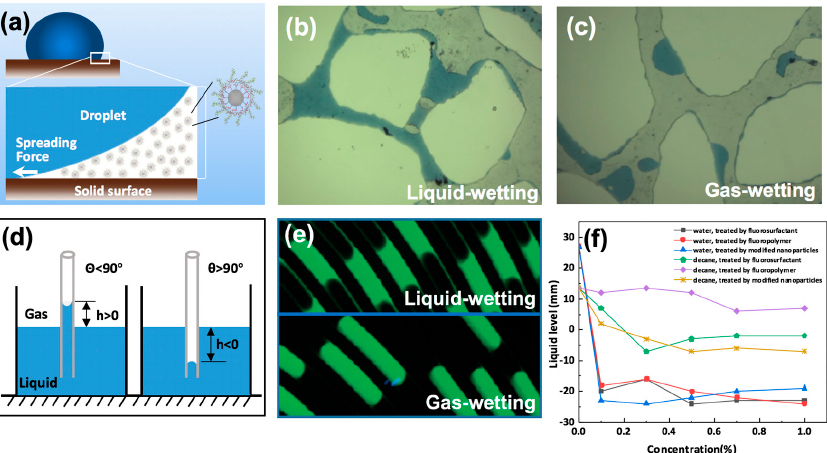
Figure 10. The movement of fluids in porous media and capillary: ( a ) detachment of liquid droplet in a liquid–liquid–solid system; ( b ) water in a pore throat with liquid-wetting; ( c ) water in a pore throat